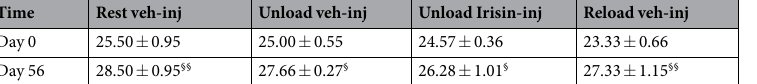
X-ray imaging of intact animals showed a generalized increase in radio density in the long bones of unloaded mice treated with r-Irisin compared to those treated with vehicle (Fig. 1a). Through visual inspection of radi- ographs, we observed in the femurs the major difference in radio density among groups of mice, as indicated by arrows. Moreover, as previously demonstrated 15 , X-ray imaging showed increased radio density in both